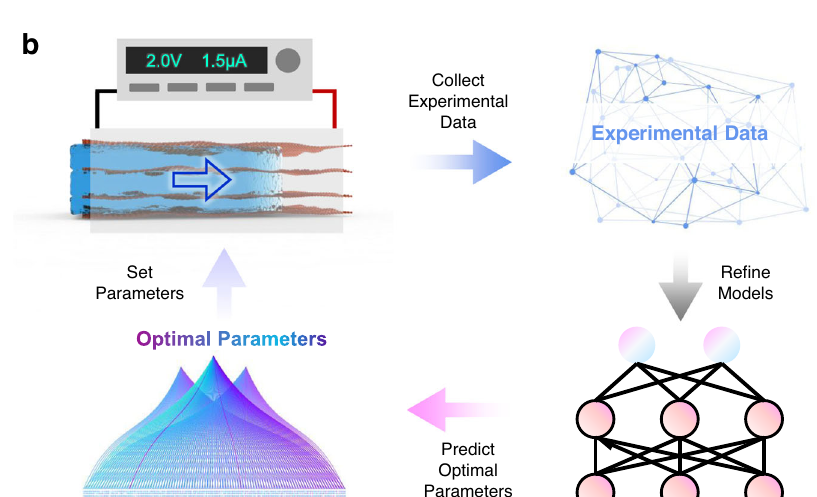
generation performance data of 2D-WEGs with different structural parameters are collected experimentally. The newly collected data and the previous data are then used to re fi ne the opt-models. Subsequently, a differential evolution algorithm is used to obtain several new combinations of structural parameters based on the predictions of opt-models, and reconstruct 2D-WEGs, and collect experimental data